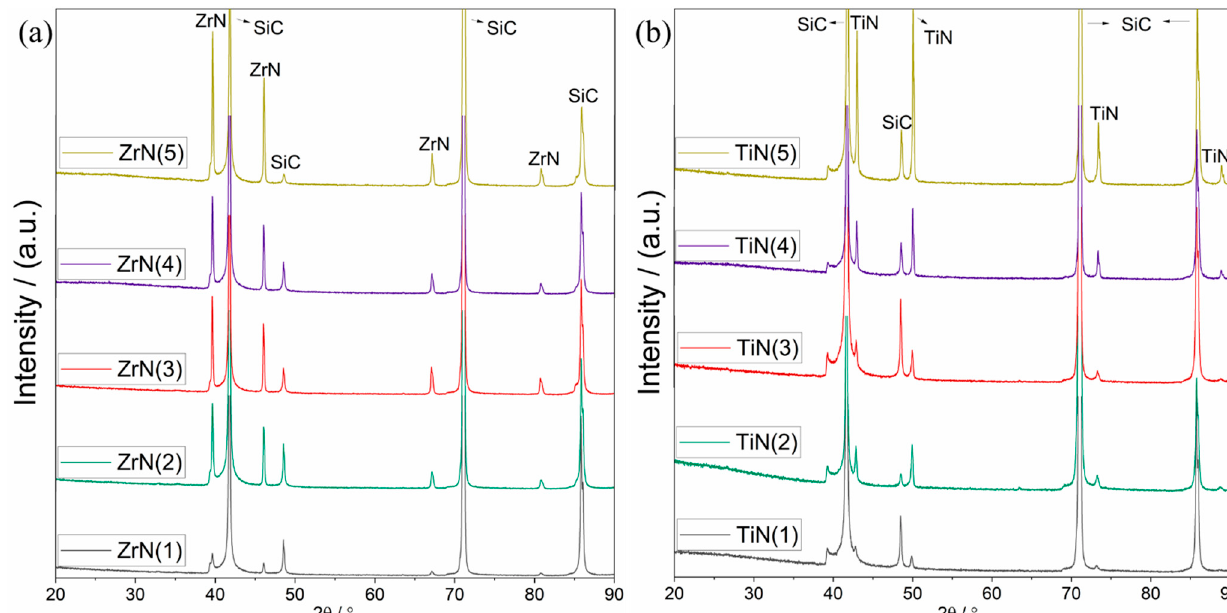
Figure 9. XRD patterns of nitrides by dipping method before joining. ( a ) ZrN; ( b ) TiN.